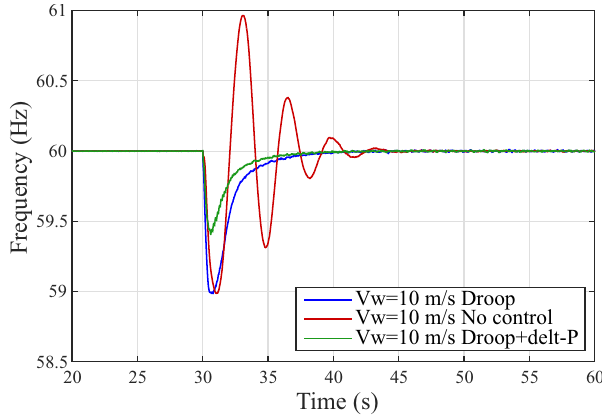
Figure 9. Frequency comparison for wind speed of 10 m/s.